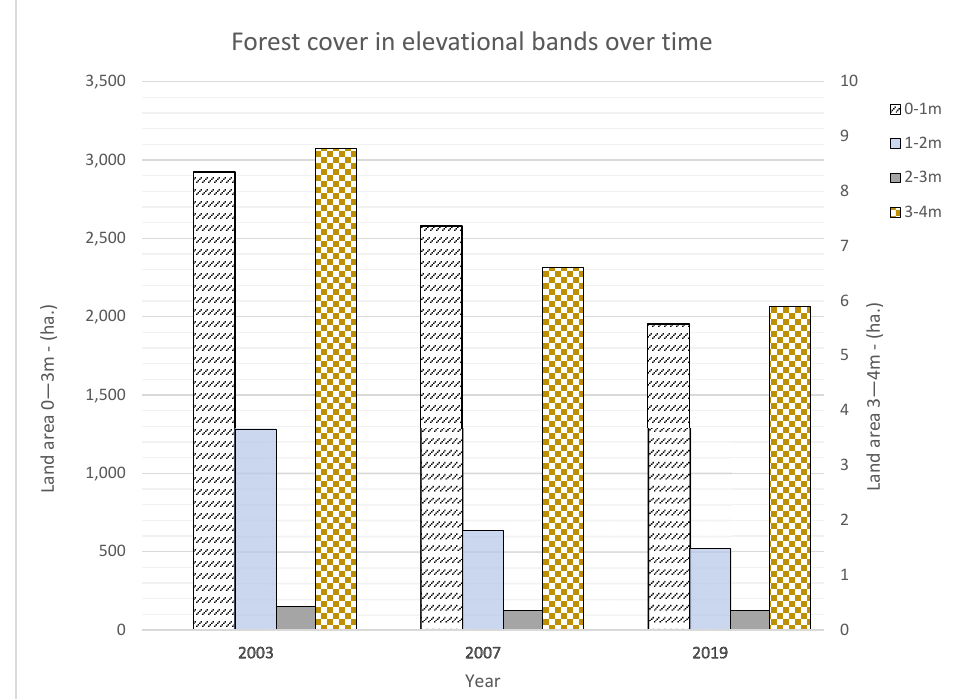
respondence between climate and water pressure in coastal areas. An increase in the av ‐